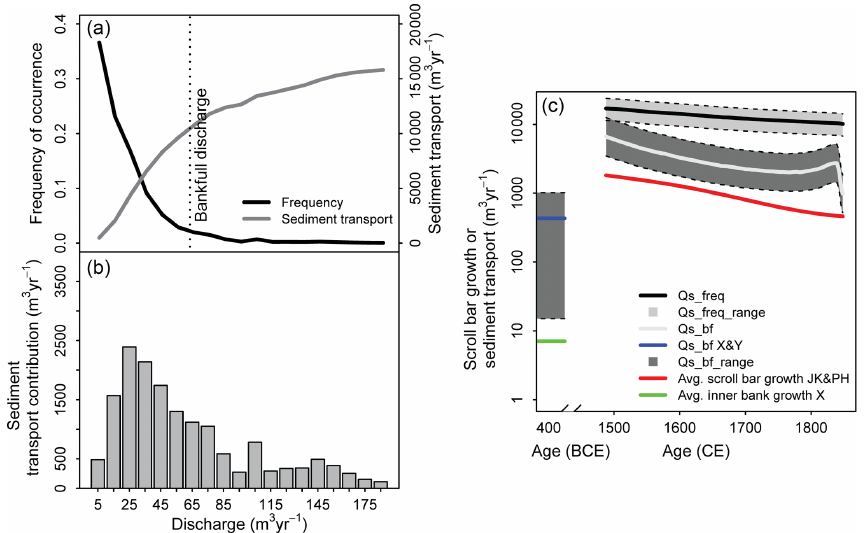
Figure 10. Sediment transport budgets calculated from present-day flow conditions and from meander migration. (a) Discharge and sediment transport characteristics of the Overijsselse Vecht derived from hourly discharge data from 1995 to 2015 of the gauging station Mariënberg, including the frequency of each discharge class over a year on a frequency scale from 0 to 1 and the sediment transport as a function of discharge for a randomly selected year (1546CE) in the Junnerkoeland meander bend. (b) Histogram of the sediment transport contribution as a function of discharge. (c) The sediment transport and average scroll bar growth over time (JK: Junnerkoeland, PH: Prathoek, X & Q : Palaeochannels X and Q ). The abbreviations Q s , freq and Q s , bf are explained in Sect. 3.8. The inner bank growth X refers to the growth rate of the channel deposits on the inner bank at Palaeochannel X , assuming a constant lateral migration rate. Shading indicates the 16th and 84th